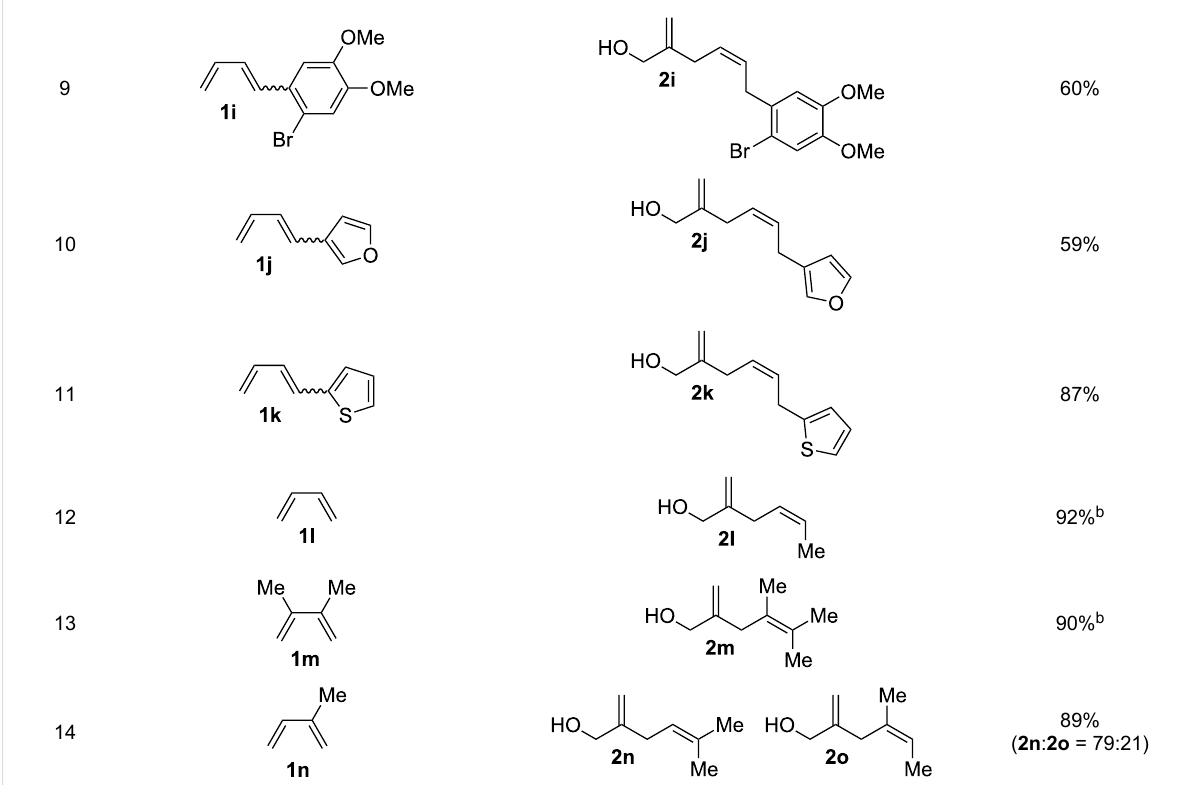
Table 1: Results of the cobalt-catalysed 1,4-hydrovinylation reaction of TMS-protected allylic alcohol with 1,3-dienes of type 1 . (continued)